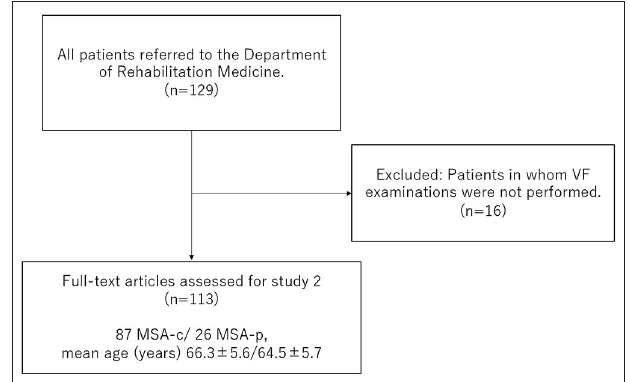
FIGURE 1 | Flow diagram of study